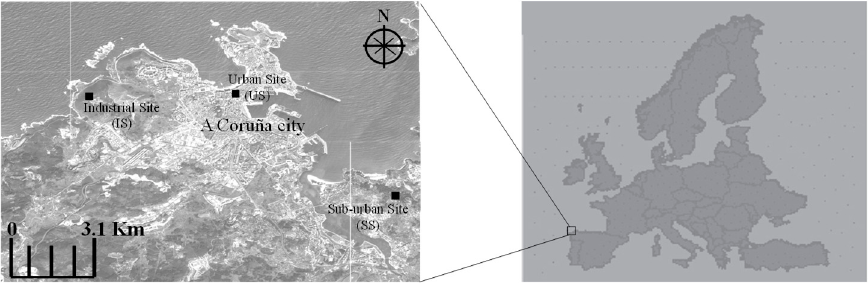
Figure 1. Sampling sites at the A Coruña City.